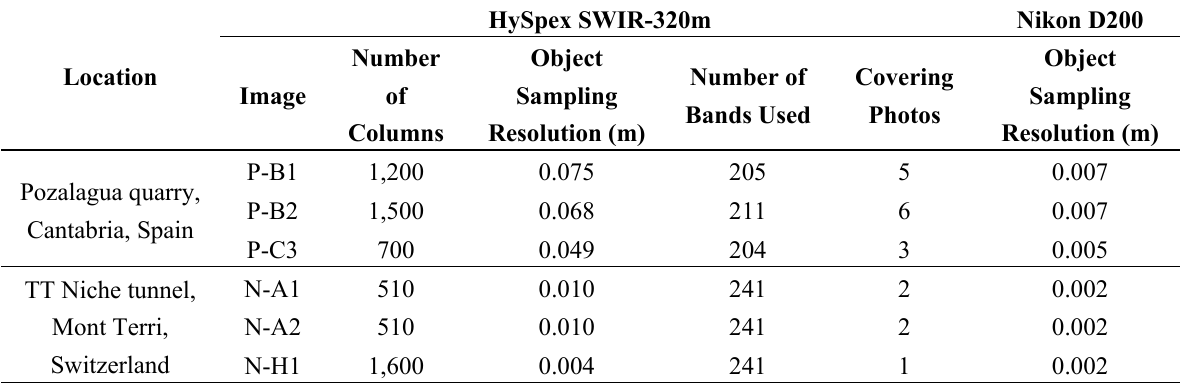
Table 1. Characteristics of SWIR and VIS images used for experimentation.